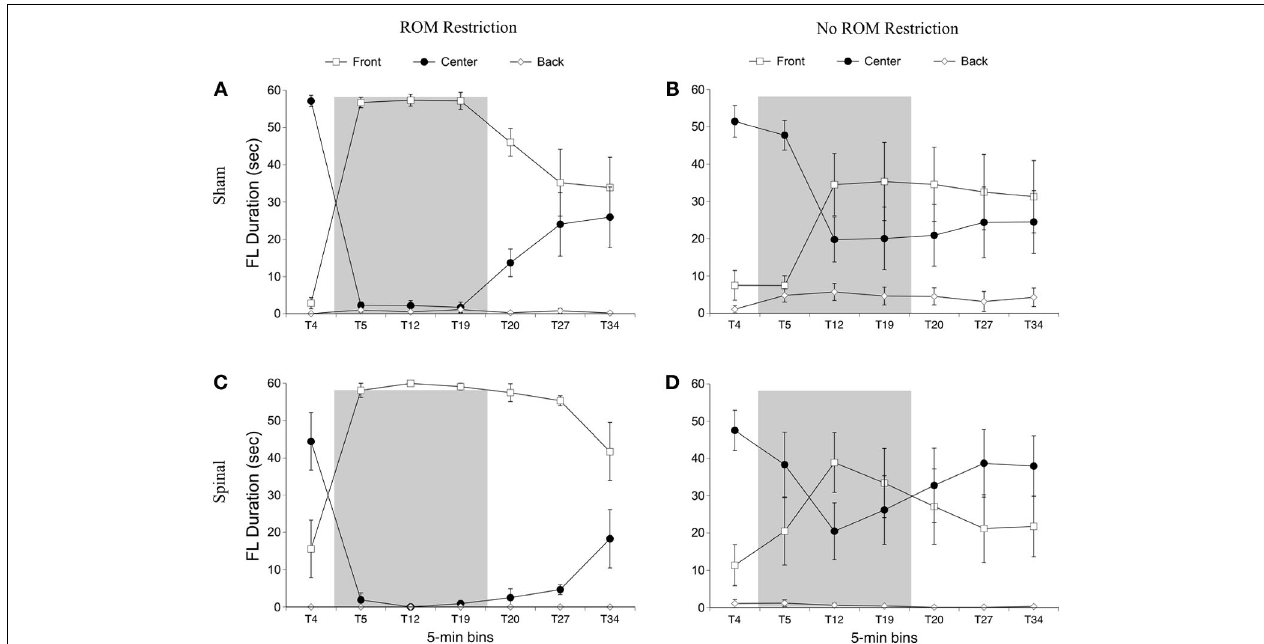
FIGURE 6 | Rostral-caudal forelimb trajectories for sham and spinal P10 ratsbyROMrestrictioncondition. Graphsshowdurationoftimespentinfront, center, and back trajectory areas for 1-min sections during baseline, the ROM restriction period, and the post-ROM restriction period for (A) sham subjects